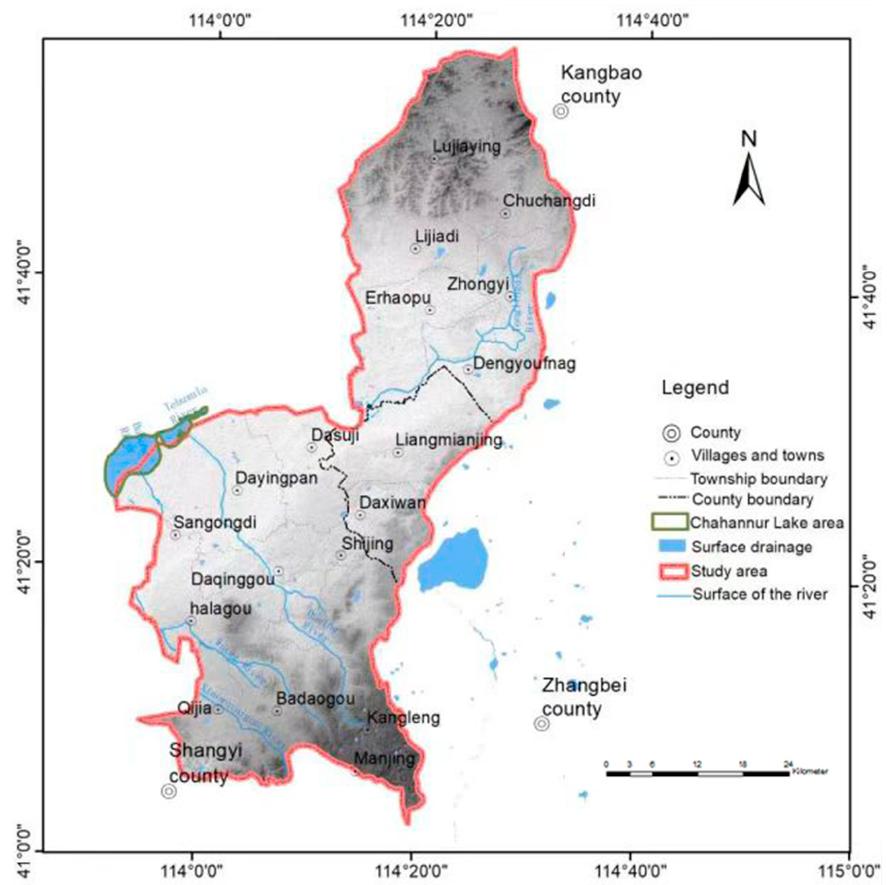
Figure 1. Geographical location map of the Chahannur watershed.